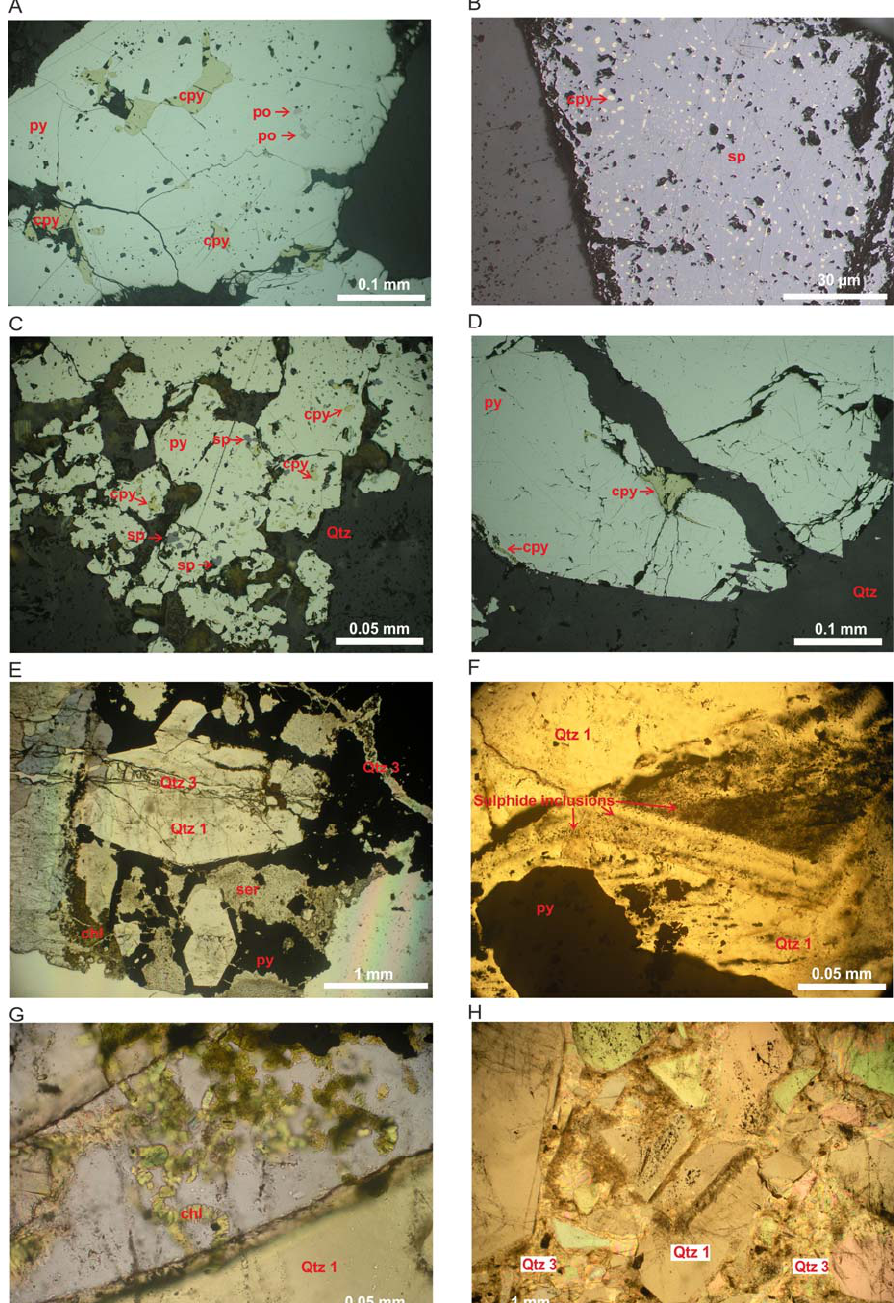
Figure 2. Typical petrographic features of the studied VMS stockwork samples. ( A ) Pyrrhotite found as inclusions in pyrite 1 while chalcopyrite formed later grains among pyrite crystals (Vigonzano). ( B ) Chalcopyrite disease in early sphalerite (Bargone). ( C ) Coarse grained pyrite containing chalcopyrite and sphalerite inclusions. Coarse grained quartz precipitated later among pyrite crystals (Campegli). ( D ) Coarse grained pyrite is cut by a younger chalcopyrite veinlet. Opaque minerals are cut by a younger coarse grained quartz (Boccassuolo). ( E ) Early quartz (Qtz 1) is surrounded by younger pyrite and cut by late quartz (Qtz 3) (Vigonzano). ( F ) Sulfide inclusions (sphalerite and pyrite) in growth zones of early quartz (Qtz 1) prove their co-precipitation (Vigonzano). ( G ) Rosetta-like early chlorite in early quartz (Qtz 1) (Vigonzano). ( H ) Early quartz (Qtz 1) showing growth zoning is brecciated by later, fine grained quartz (Qtz 3) (Vigonzano). Abbreviations used: chl: chlorite; cpy: chalcopyrite; po: pyrrhotite; py: pyrite; ser: sericite, sp: sphalerite; Qtz: